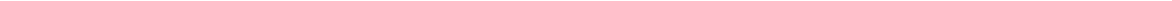
Fig. 2 Oxidation-induced conformation of PTP1B exposes an amino-terminal binding interface targeted by scFv45. a Analytical size-exclusion chromatography of PTP1B-CASA and PTP1B-CASA-mut2 in the absence or presence of 1.1-fold molar excess of scFv45. b Mass spectra of PTP1B-CASA and PTP1B-CASA-mut2 in the absence or presence of 1.1-fold molar excess of scFv45, digested with AspN endoprotease (1:500 w/w) for 30 min. Peptide masses de fi ning regional boundaries of PTP1B-CASA proteolytic protection are shown in bold, with those directly protected being highlighted (blue rectangle). c Mass spectra of PTP1B-CASA in the absence or presence of 1.1-fold molar excess scFv45, digested with LysC endoprotease (1:750 w/w) for 30 min, mixed with internal peptide standards (~42.5 fmol). Masses of internal peptide standards are shown in bold, with those peptide masses of PTP1B- CASA directly protected from proteolysis being enlarged and in bold. Scaled insets are of the highlighted (blue rectangle) spectral regions. All data are representative of at least two independent experiments ( n ≥ 2; a – c ). d Three-dimensional crystal structure of PTP1B-CASA, highlighting the regional boundaries corresponding to the segment protected from proteolysis upon association with scFv45 (Ile23 — Phe52). Below is the amino acid sequence of the N-terminal portion of PTP1B in which residues that were (yellow triangles) or were not (grey triangles) protected from proteolysis are highlighted. Theoretical AspN and LysC cleavage sites (underlined) and mutated residues in PTP1B-CASA-mut2 (bold) are